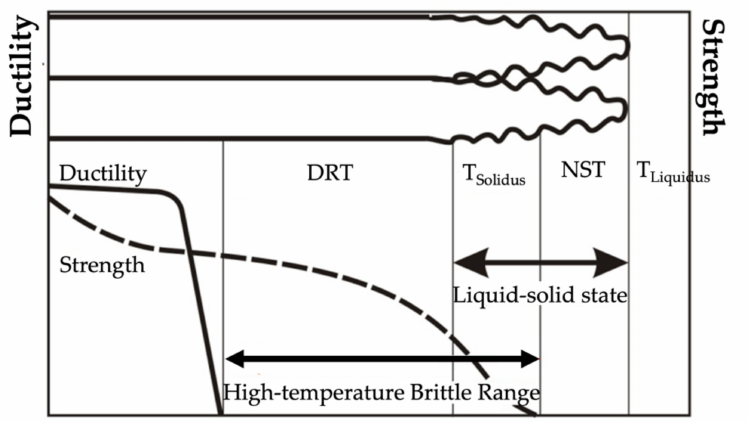
Figure 2. The high-temperature brittleness range (HTBR) determining crystallisation cracking in welded joints and padding welds. DRT—ductility recovery temperature; NST—nil strength temperature